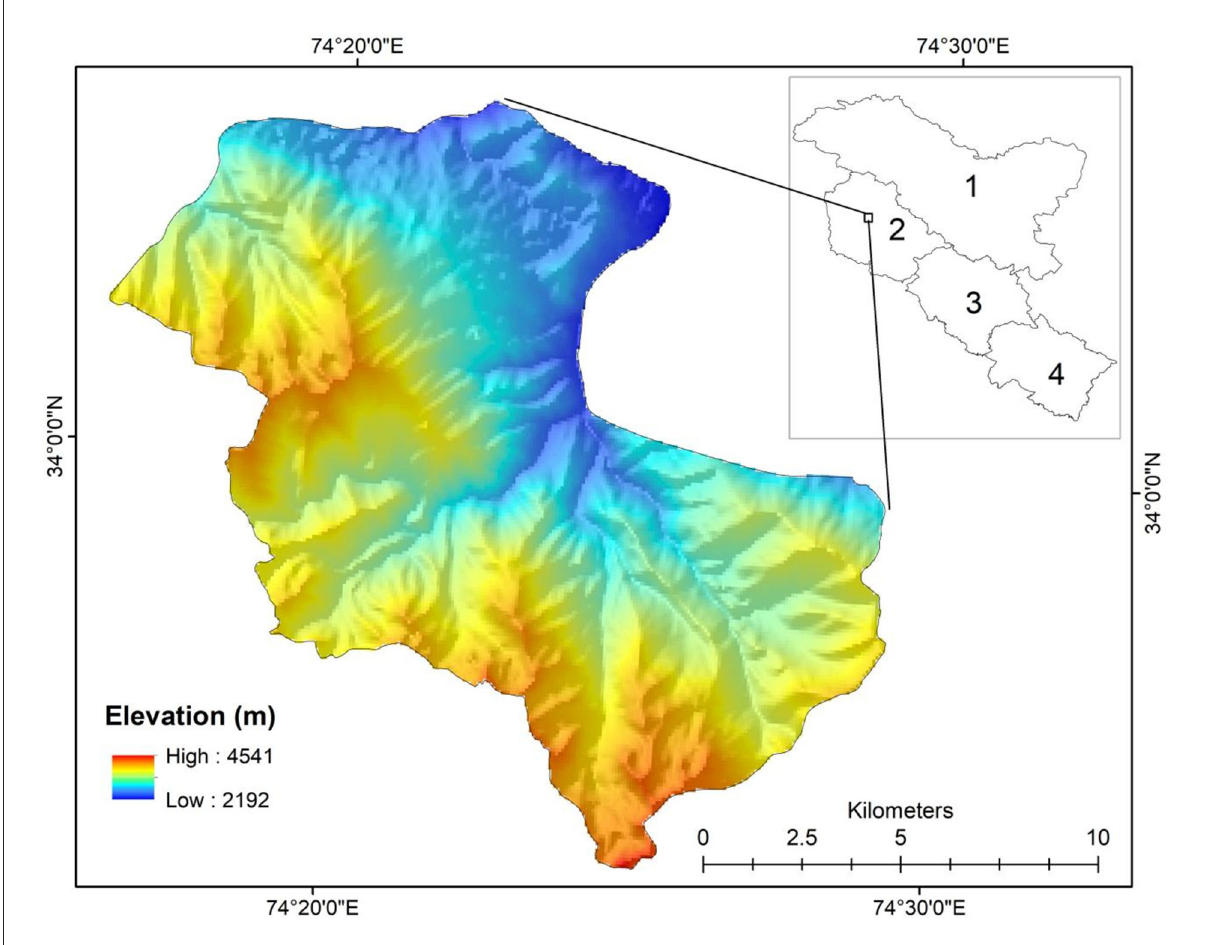
FIGURE1 Location map of Gulmarg Wildlife